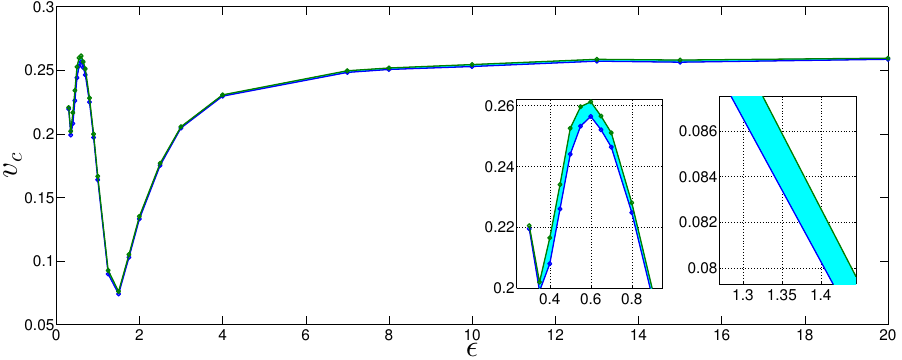
Figure 11 . The critical velocity v c as a function of ǫ found via the method of collective coordinates. The plot shows a region between two curves. The inset plots are magnified views. If q is the optimal value for a given ǫ , then for values in the interval q 0 . 005, v c should lie in the shaded ±